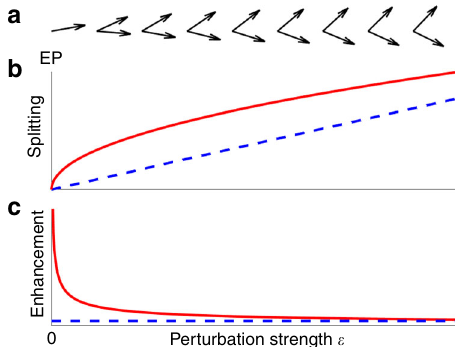
Fig. 1 Nonorthogonality of energy eigenstates and enhanced energy splitting near an exceptional point. a Illustration of nonorthogonal energy eigenstates as eigenvectors in Hilbert space. At a second-order exceptional point (EP), exactly two eigenvectors become parallel; thus, the number of linearly independent eigenvectors is reduced by one. b Energy splitting vs. perturbation strength ε for the EP (red solid curve) and a conventional degeneracy (blue dashed curve). c Splitting enhancement factor of an EP- based sensor (red solid curve) vs. ε . The blue dashed line marks the reference value of unity.